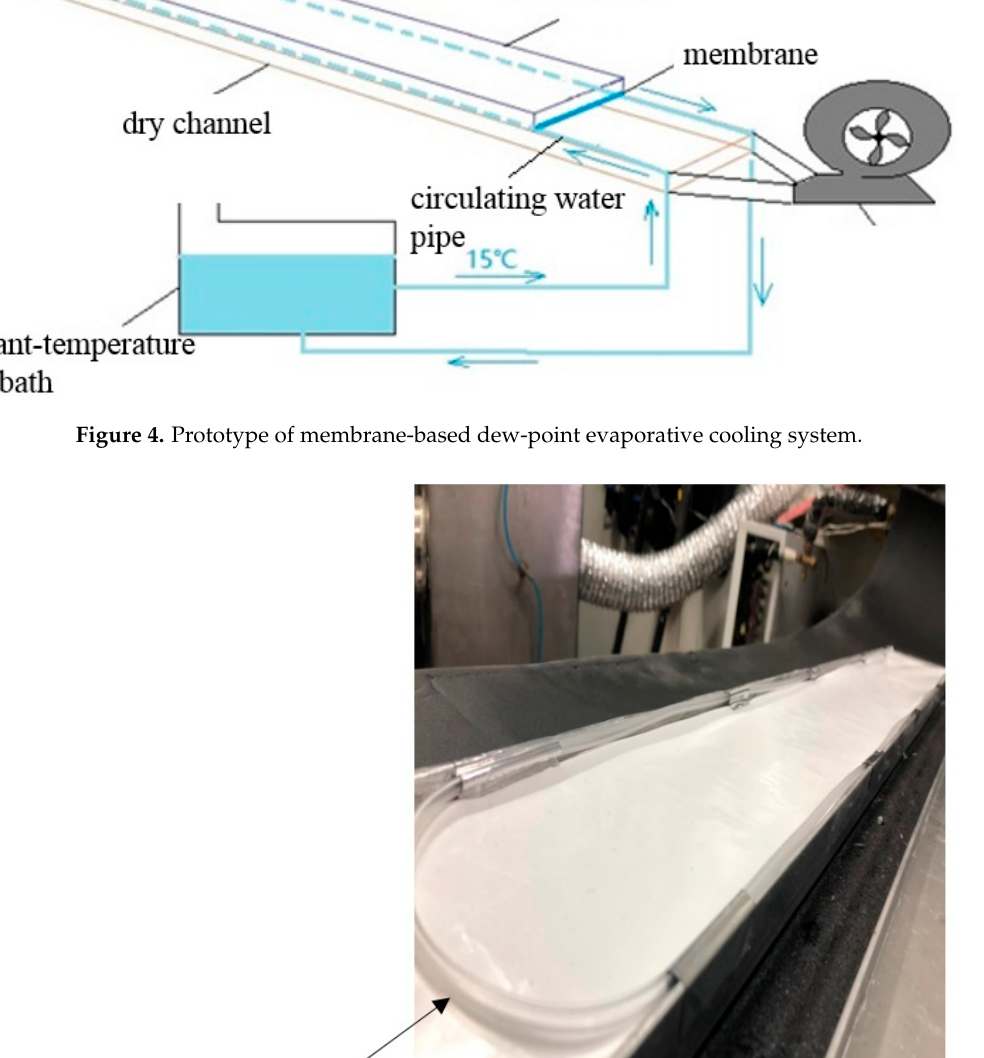
Table 1. Geometric size for the membrane-based dew-point evaporative cooling system.